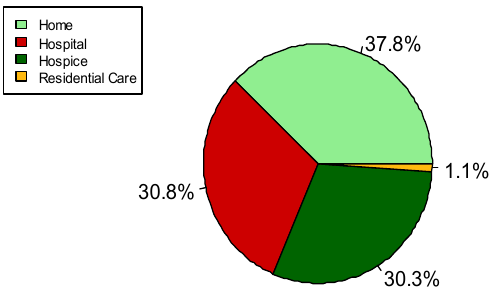
Figure 5. Pie chart of place of death. Data available for 357 subjects.